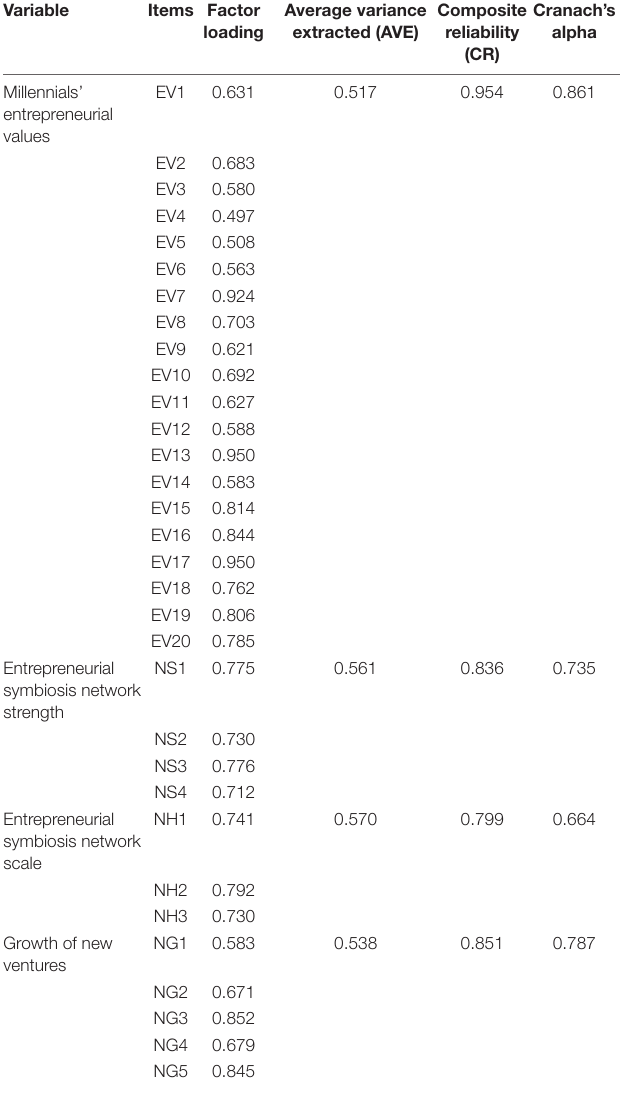
TABLE 1 | Indicators of measurement. Variable